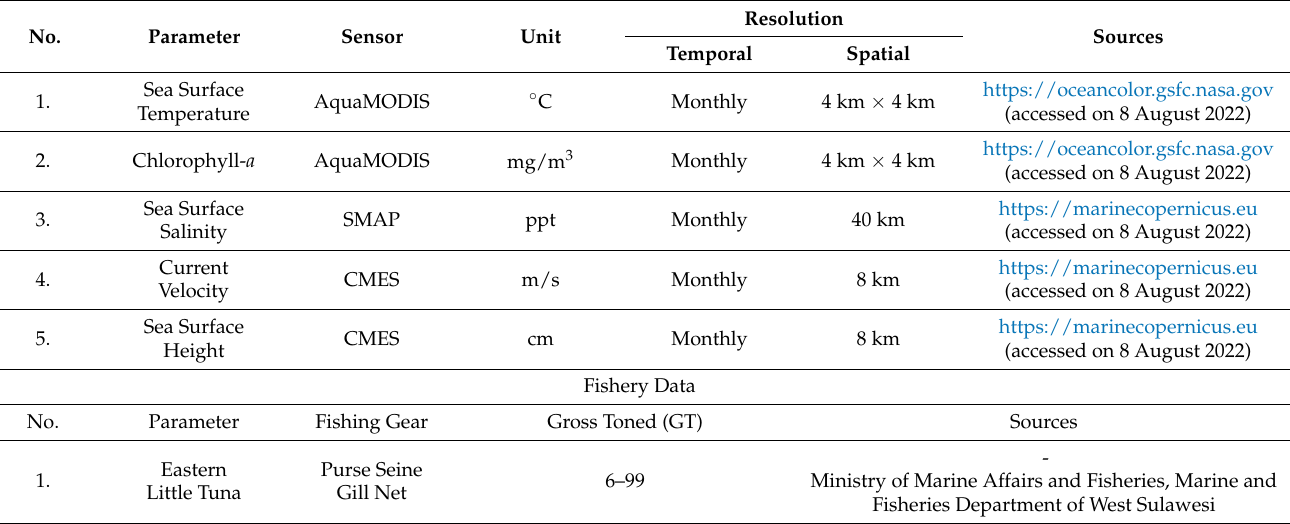
Table 1. Summary of specification of oceanographic parameter data and Eastern Little